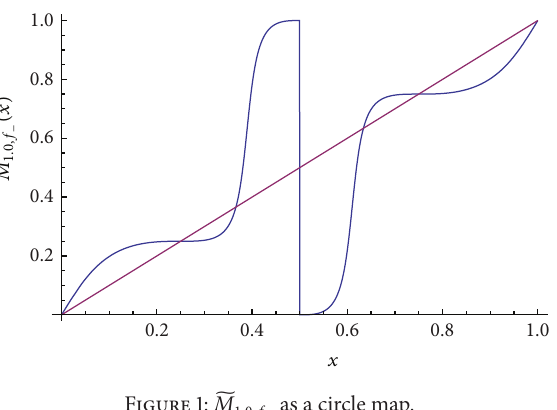
̃𝑀 Figure 1: 1.0,𝑓 − as a circle map.